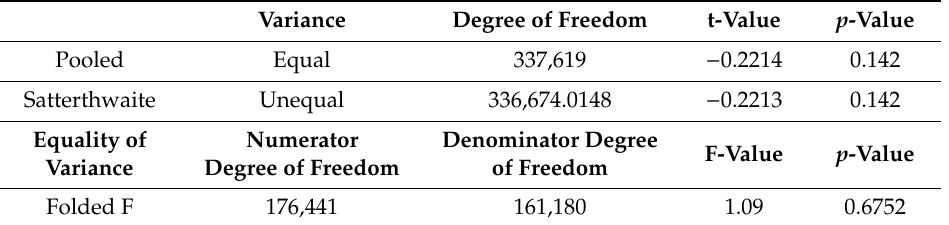
Table 14. Two-sample t -test for H3b.